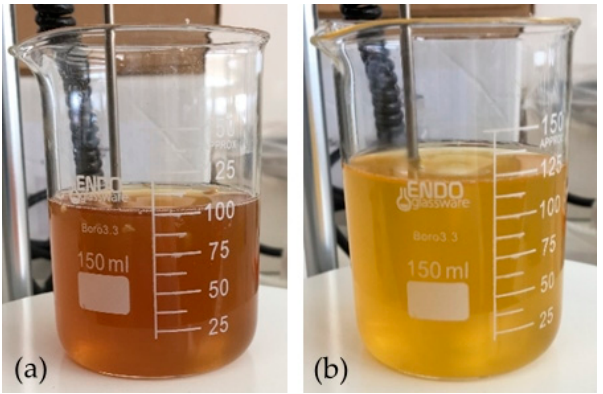
Figure 5. Solution of arabinoxylan (2% w / v ): ( a ) before the addition of hydrogen peroxide (10% v / v final ) and ( b ) after 2 h at 45 °C of reaction time.